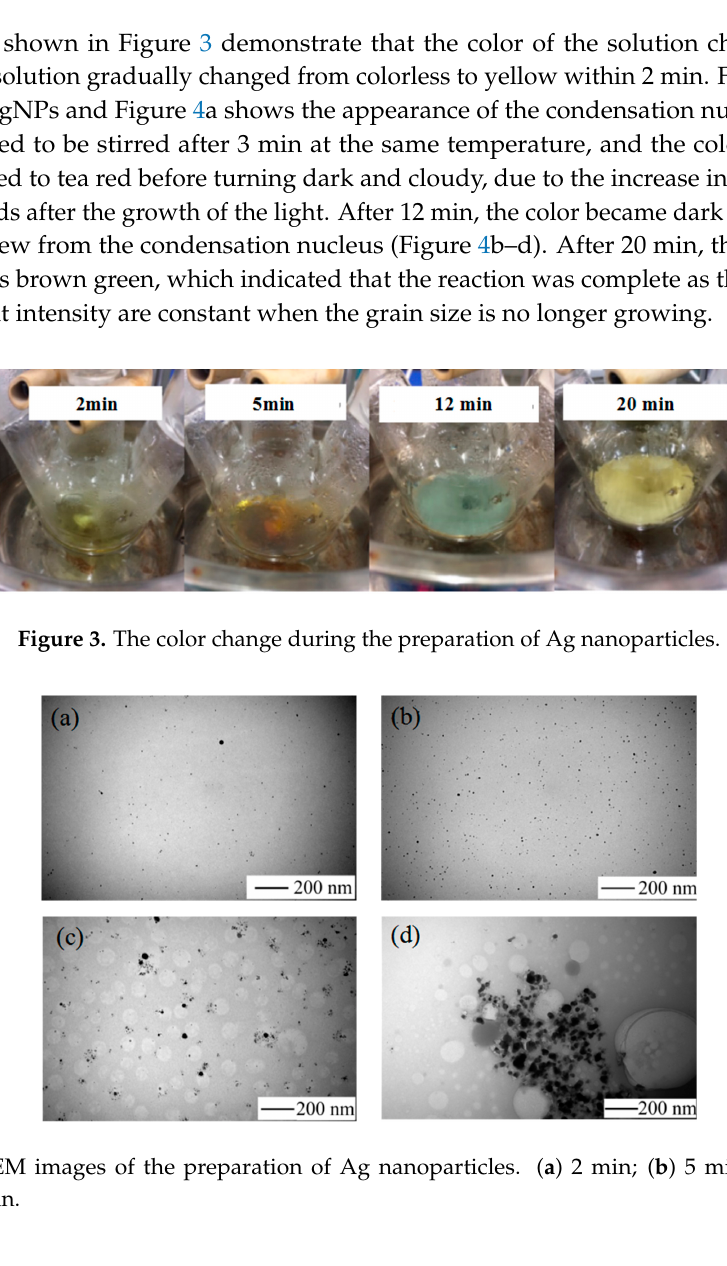
Figure 2. UV–vis extinction spectra of the products prepared at different temperatures at PEG:EG ratio of 1:2.